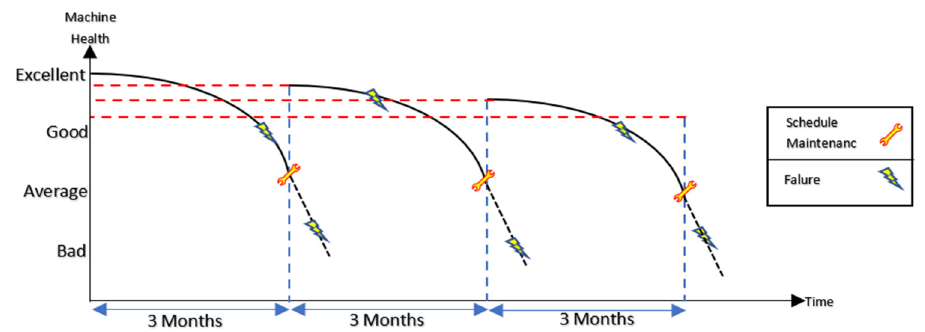
Figure 3. Repair and maintenance strategy using the preventive maintenance method.